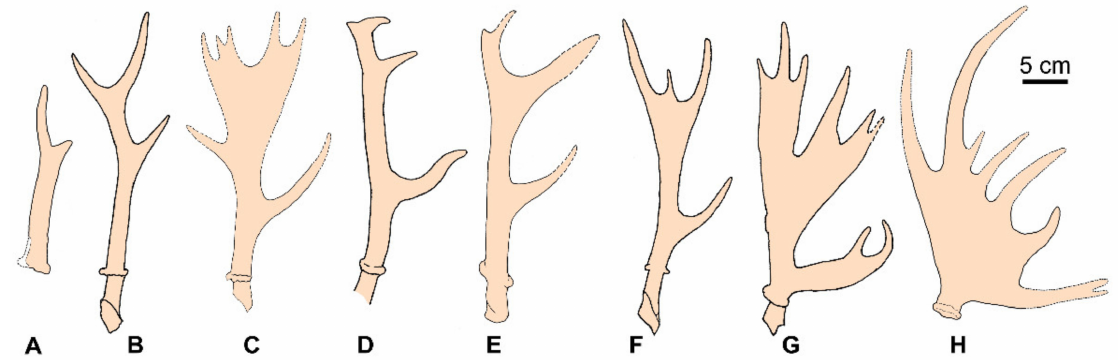
Figure 3. Diversity of antlers of the late Miocene representatives of the subfamily Capreolinae: ( A ), Lucentia iberica [31]; ( B ), Procapreolus ucrainicus [22]; ( C ), Neomegaloceros gracilis [18]; ( D ), Plio- cervus matheroni [18]; ( E ), Pavlodaria orlovi [32]; ( F ), Damacerus bessarabiae [18]; ( G ), Metadicrocerus variabilis [22]; ( H ), Cervodama pontoborealis